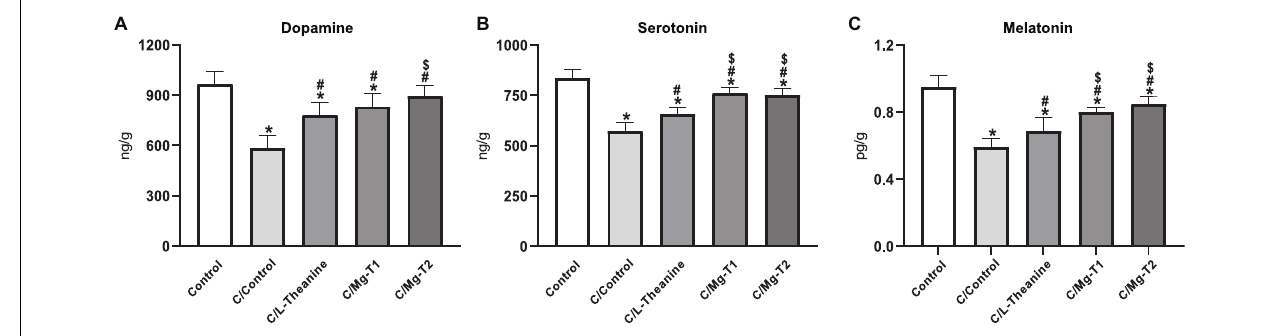
FIGURE 5 | L -Theanine and Mg- L -theanine compounds improve sedative neurotransmitters. Dopamine (A) , serotonin (B) , and melatonin (C) levels in the brain. One-way ANOVA with Tukey’s HSD was performed for multiple comparisons and values are represented as mean ± SD. * p < 0.05: compared to control, # p < 0.05: compared to caffeine control, $ p < 0.05: compared to L